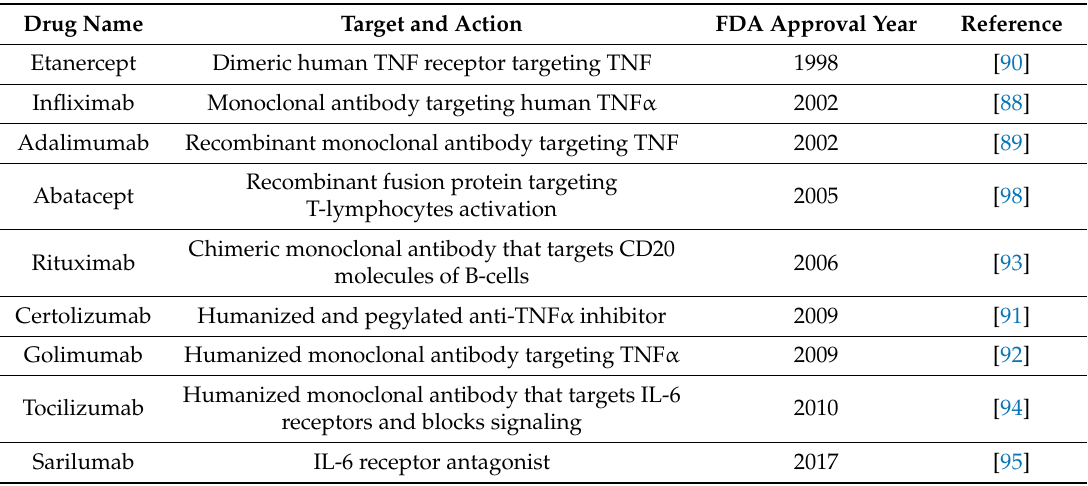
Table 2. Current Food and Drug Administration (FDA)-approved drugs targeting immune responses for the treatment of rheumatoid